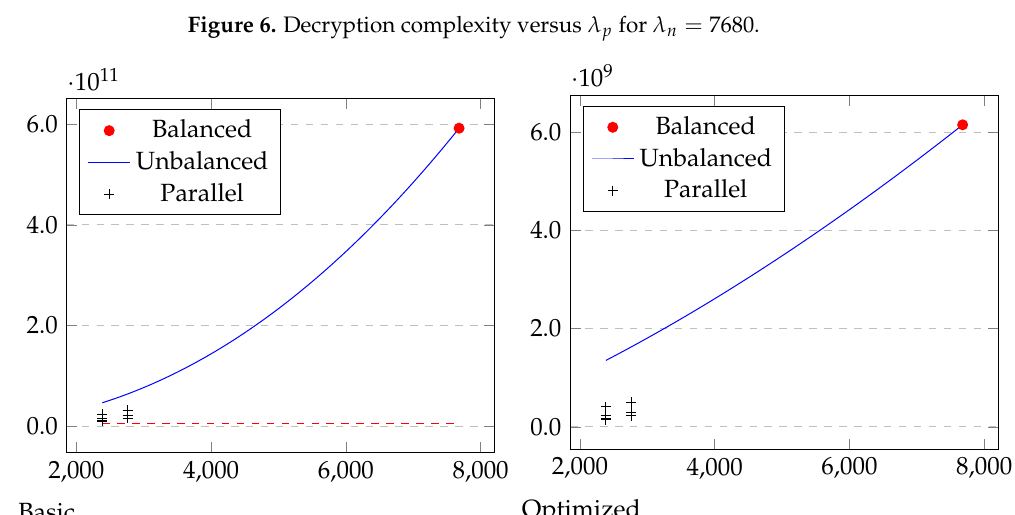
Figure 7. Decryption complexity versus λ p for λ n =